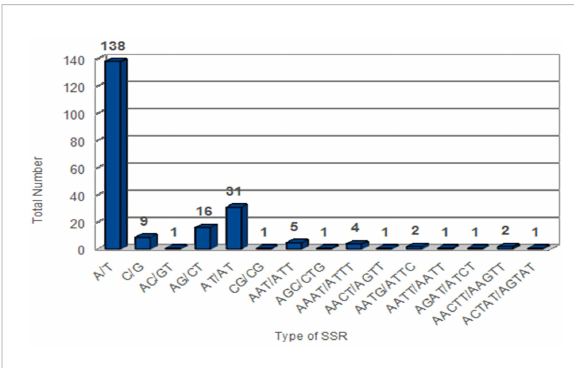
FIGURE 5 Distribution of SSRs based on their repeat type in Piper nigrum.